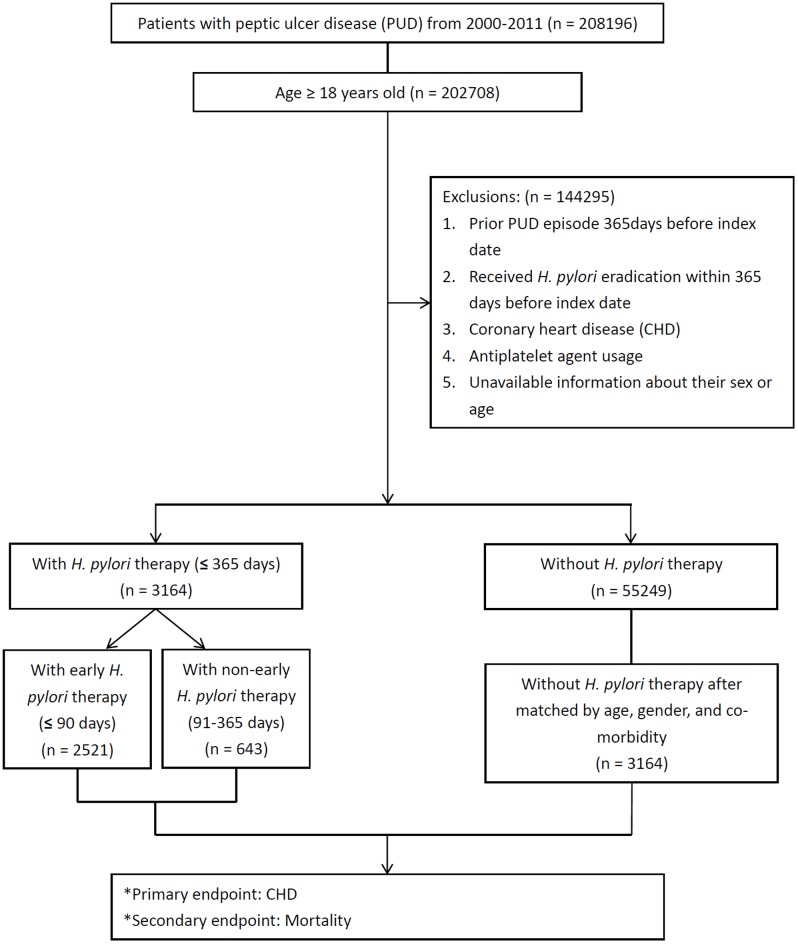
Schematic flowchart of study design.